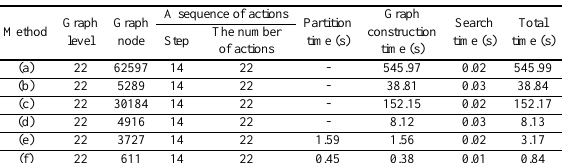
Table 3. Experimental results of case (a) ∼